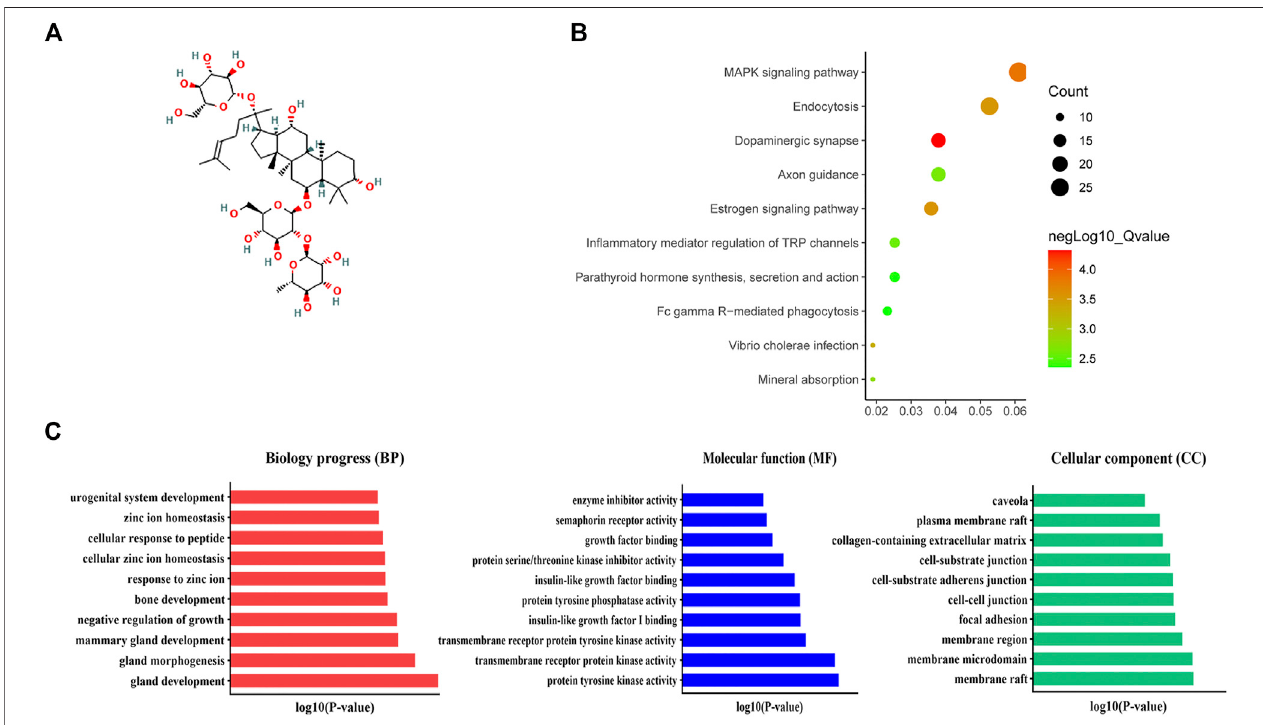
FIGURE 5 | KEGG and Go analysis. (A) Structural formula of ginsenoside Re. (B) Revealed the 10 signi fi cantly enriched pathways in KEGG analysis. (C) The top terms of molecular functions (MF), biological processes (BP), and cellular components (CC) in GO enrichment